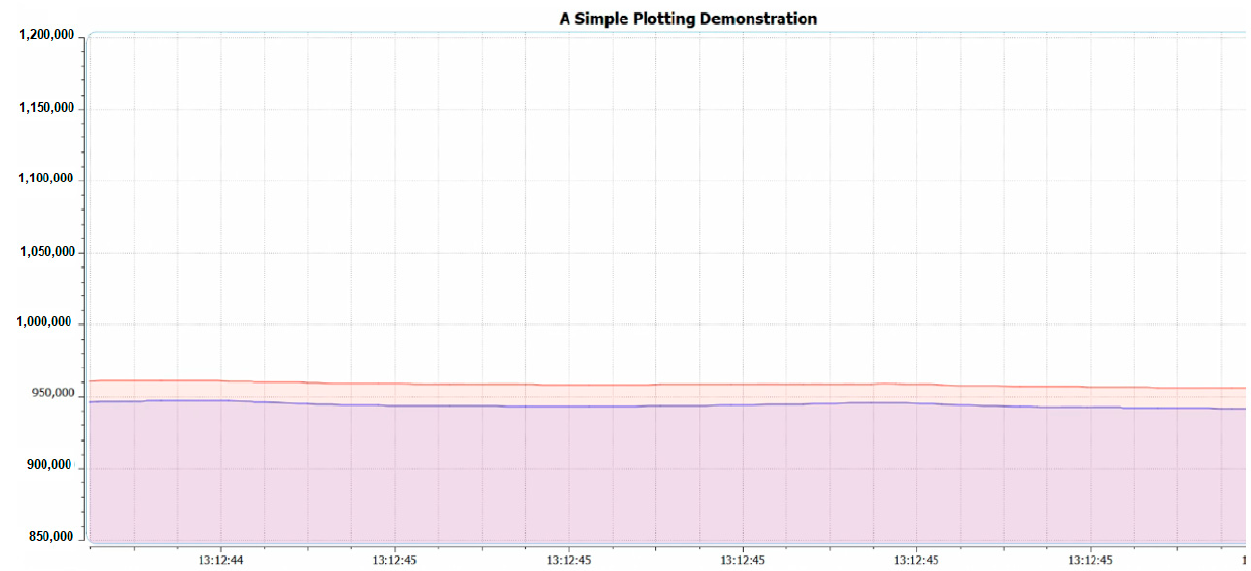
Figure 5. MAGIC_ACCEPTABLE_INTENSITY_DIFF is suitable.